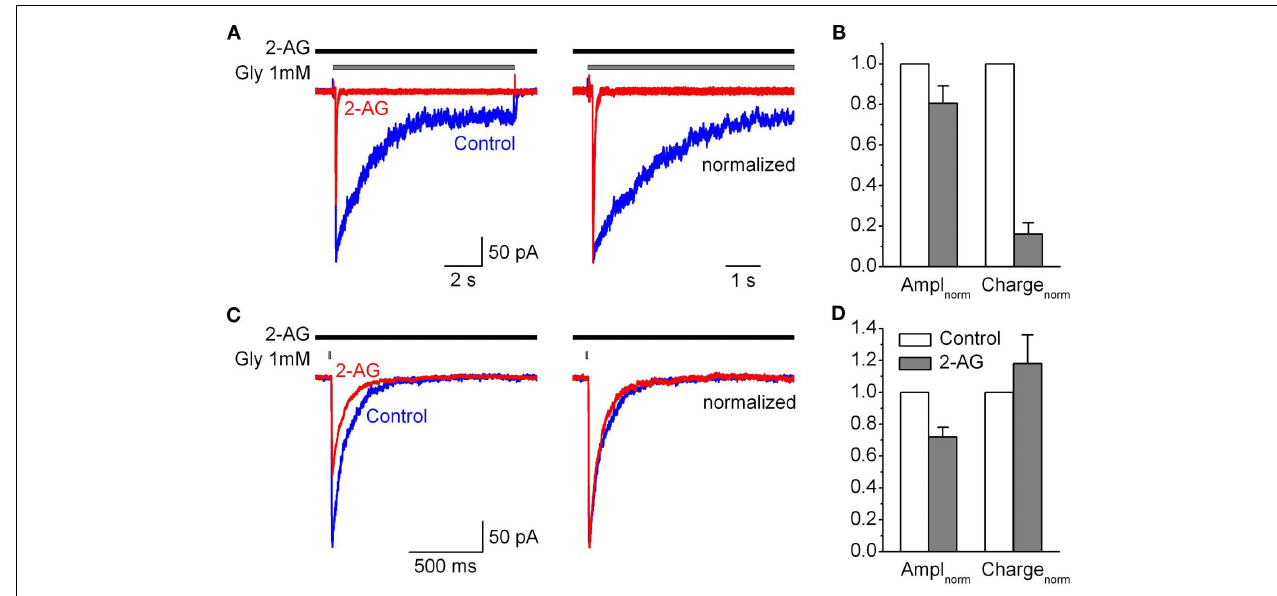
superimposed. (B) Summary plots showing the effects of 1 μ M 2-AG on I GlyR amplitude and charge transfer of I Gly normalized by peak amplitude. Data are plotted as a fraction of control values. (C,D) The same as in (A,B) , but for (2ms) pulse of 1mM glycine.